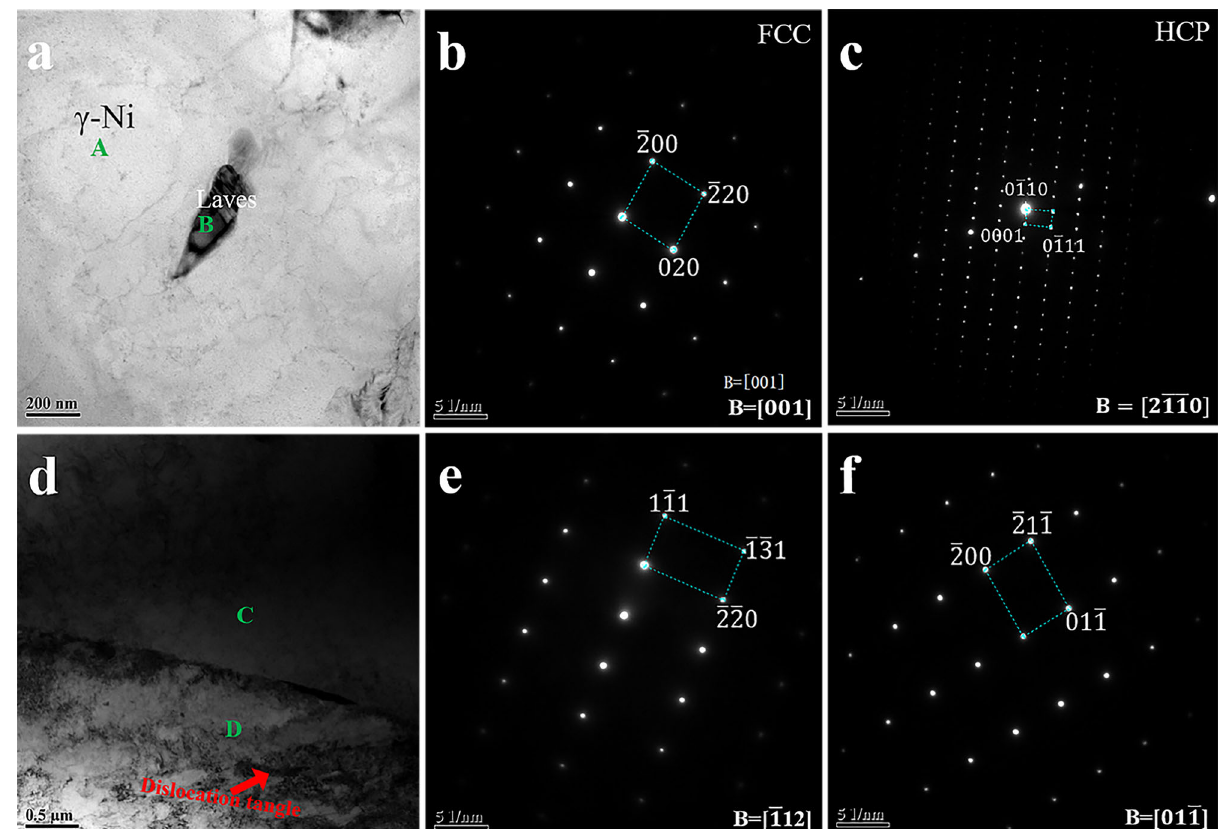
Fig. 4 TEM image of Inconel 625 coatings on Q245R steel (S6). a Top view; b , c selected area diffraction patterns for phase A and B corresponding to a ; d bottom to top views; e , f selected area diffraction patterns for phase C and D corresponding to ( d ). Table 1. EDS results of lavas phase.